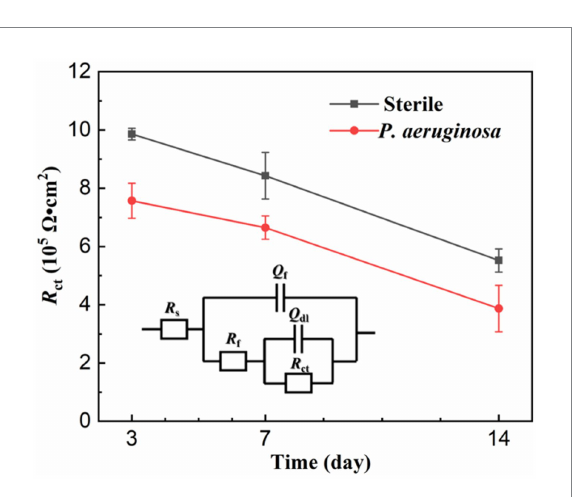
FIGURE 7 Potentiodynamic polarization curves of the HEA coupons after 14 days of immersion in sterile and P. aeruginosa -inoculated